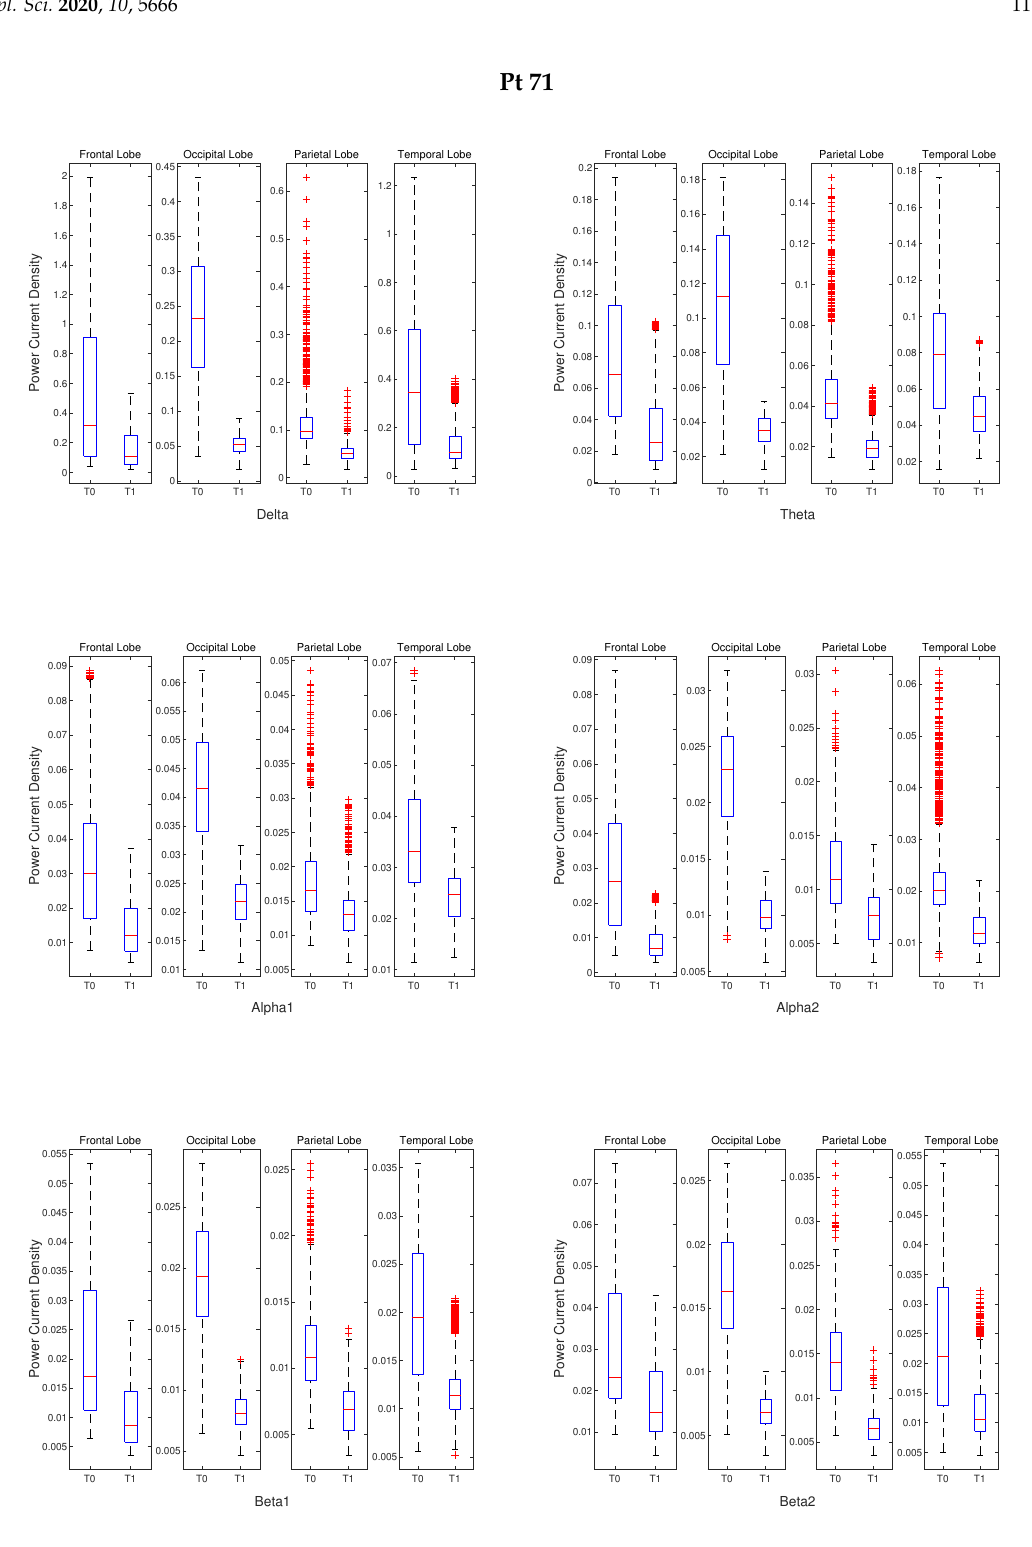
Figure 6. Boxplot of the power current density of patient 71 at time T0 and T1 for each frequency sub-band and each region of interest (frontal, occipital, parietal, and